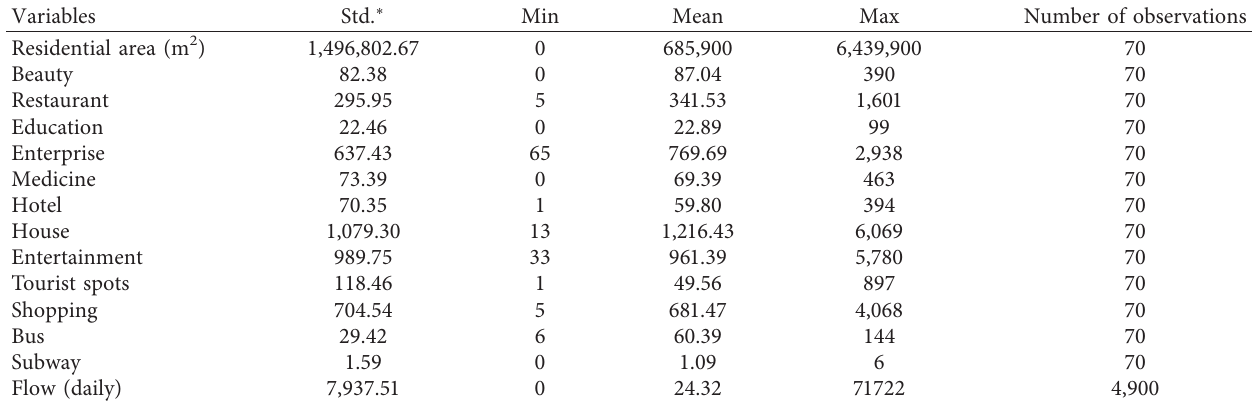
Table 1: Statistics of variables in